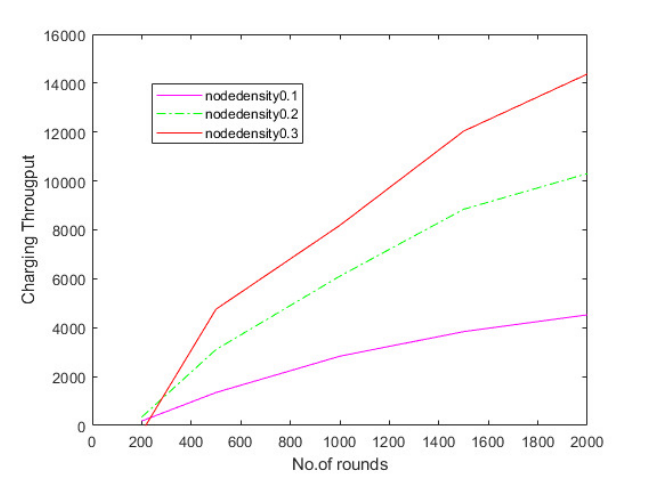
Figure 10. Comparative analysis of charging throughput for CETS at various node densities.